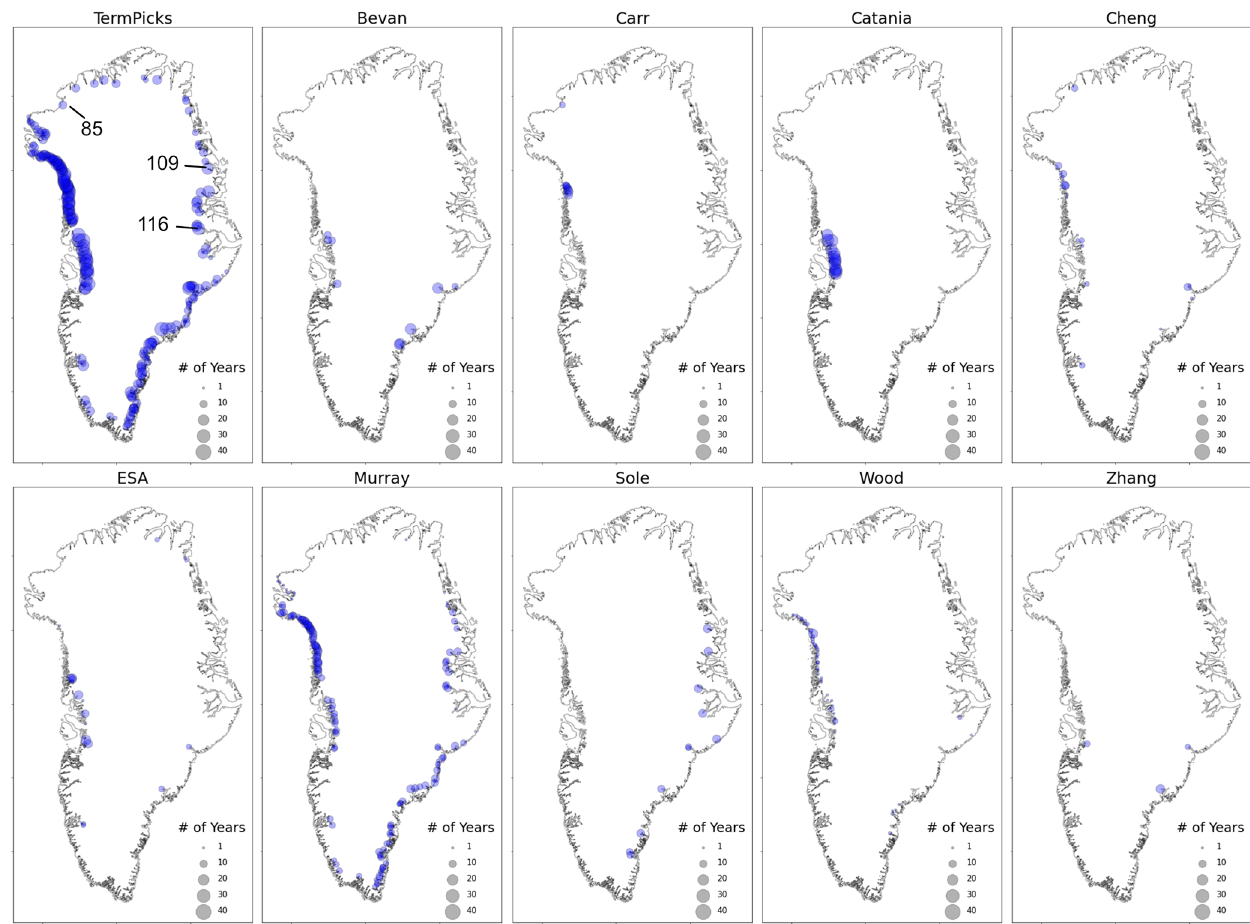
Figure 8. Locations of glaciers that include terminus delineations for at least three unique months, which is the minimum number of traces required to resolve seasonality, for the entire TermPicks data set and a subset of authors. The size of the blue circle indicates how many years that there are enough traces to resolve seasonality, ranging between a single year to up to 40